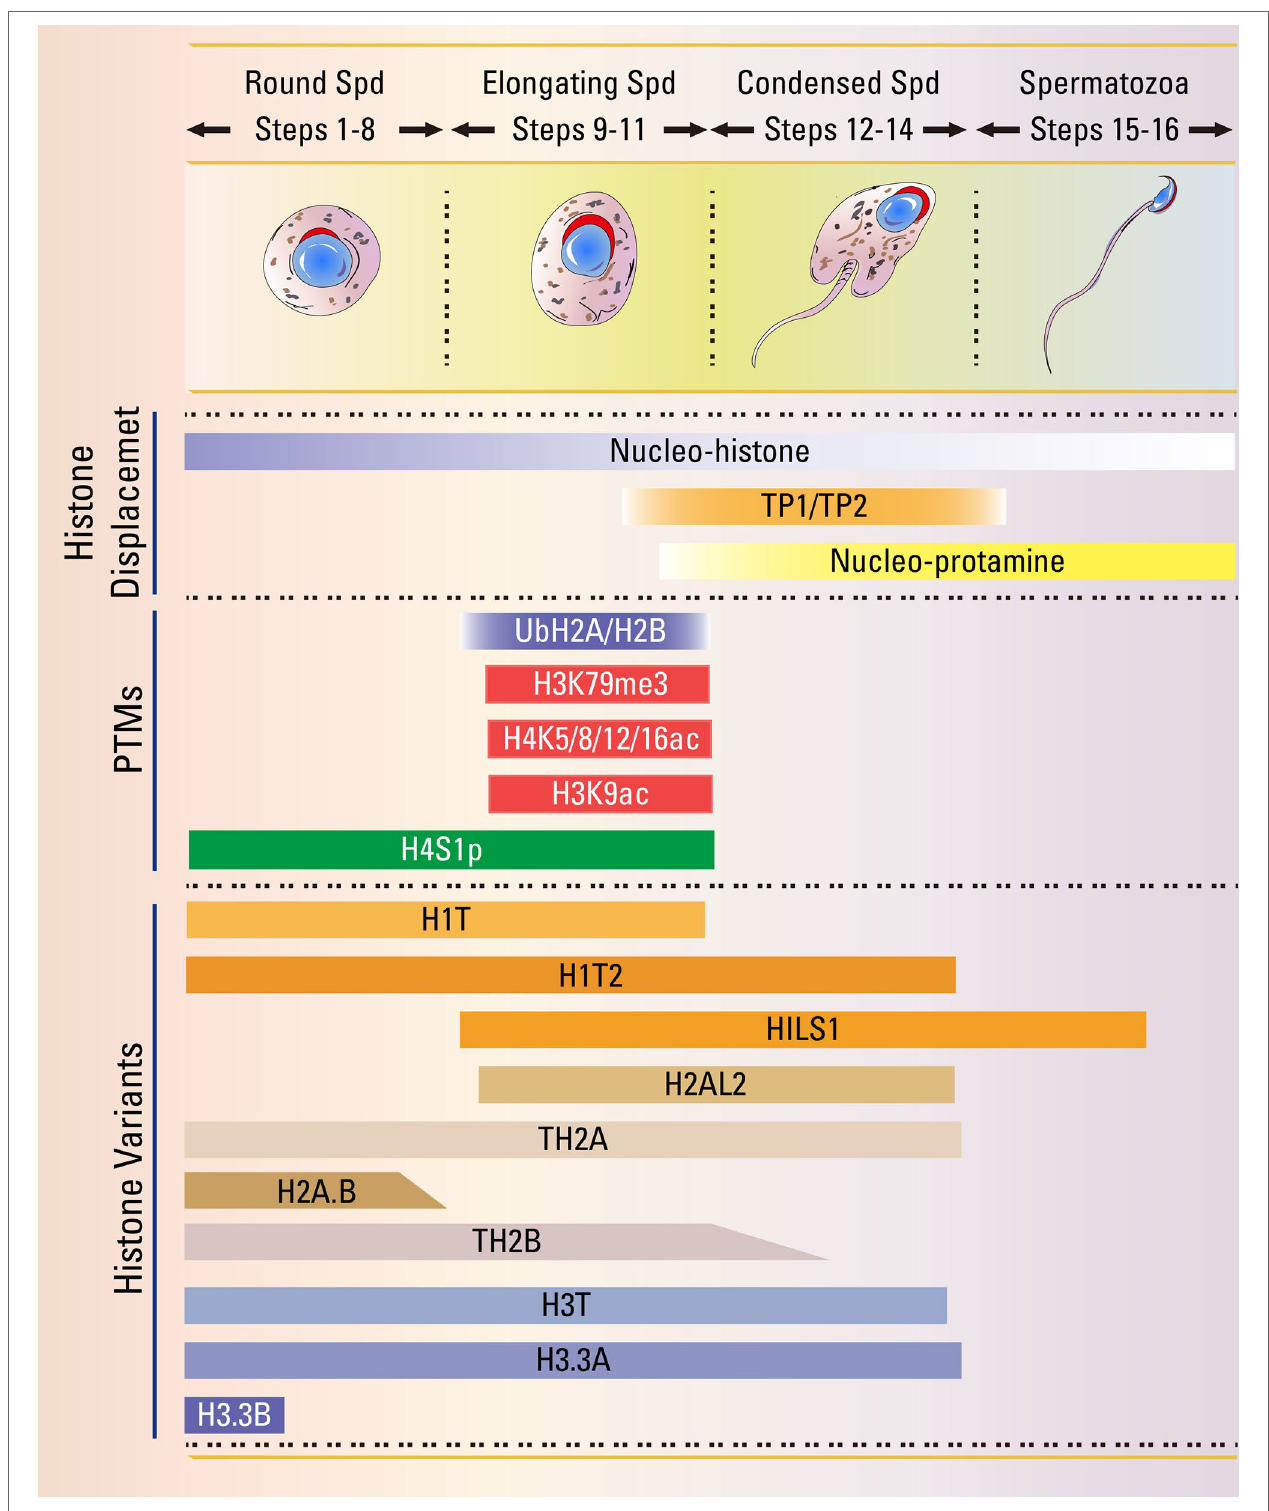
FIGURE 1 | Summary of critical time points and epigenetic events during the histone-to-protamine transition. The haploid germ cells undergo a dramatic morphological change, and nuclear chromatin re-organization starts from round spermatid (Spd) to mature spermatozoa. Detailed studies of the indicated histone variants and histone modification might establish the precise epigenetic events of